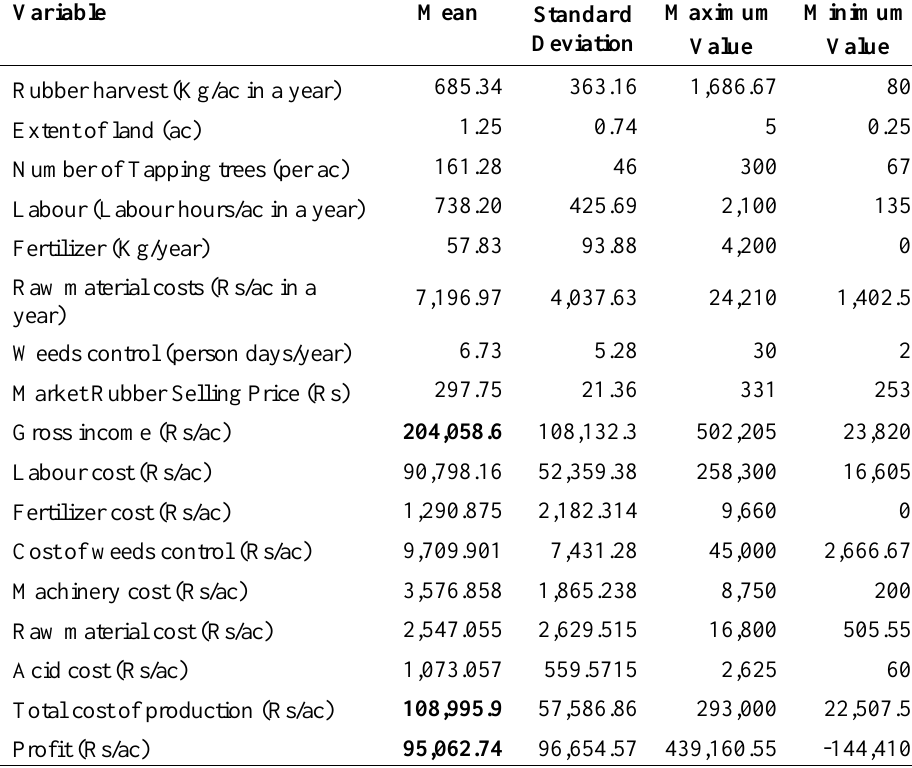
Table 3: Summary Statistics of the Sample